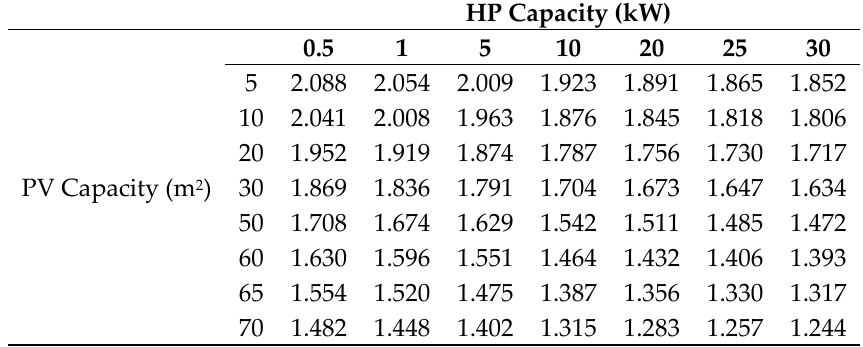
Table 5. Annual CO 2 emission for single building under Different PV and HP capacity (×10 4